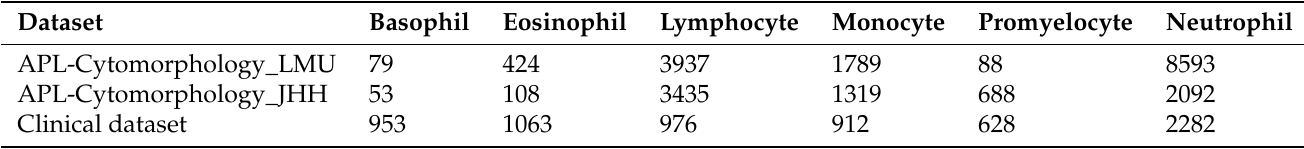
Table 2. The amount of six classes of leukocytes of the three datasets.